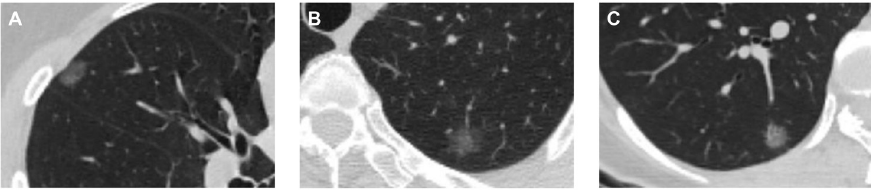
Fig 1. CT images and features of three pure ground-glass nodules with different pathological results. (A) A 39-year-old woman with a pure ground-glass nodule (pGGN) in the right middle lobe was diagnosed pathologically with minimally invasive adenocarcinoma (MIA). The CT image shows that the size of the pGGN is 1.34 cm. The mean CT value of the whole nodule (mCTv) was –694.21 HU, as measured using a region of interest (ROI) after 3D volume segmentation, and the rad_score was –1.340. (B) A 63-year-old woman with a pGGN in the left upper lobe was diagnosed pathologically with lepidic predominant adenocarcinomas (LPA). The CT image shows that the size of the pGGN is 1.55 cm. The mCTv was –708.496 HU, and the rad_score was –1.139. (C) A 42-year-old woman with a pGGN in the right lower lobe was diagnosed pathologically with non-lepidic predominant adenocarcinoma (NLPA). The CT image shows that the size of the pGGN is 1.22 cm. The mCTv was –566.138 HU, and the rad_score was